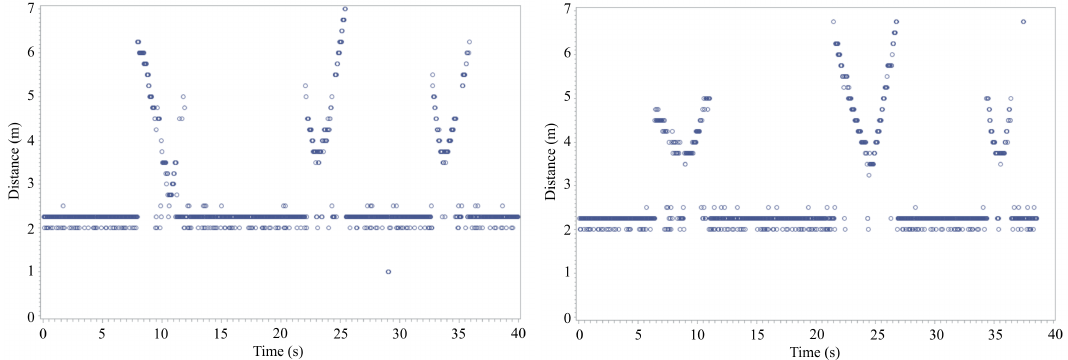
Figure 9. Drone distance measurement experiment results using version one without reflection tape ( left ), and with reflection tape ( right ) [10].